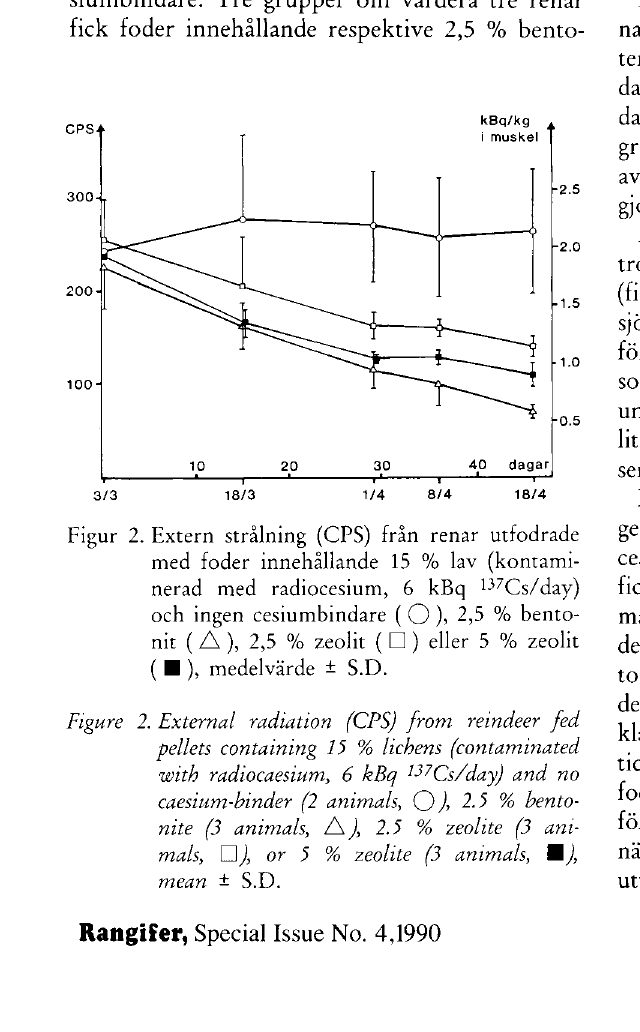
Figure 2. External radiation (CPS) from reindeer fed pellets containing 15 % lichens (contaminated with radiocaesium, 6 kBq 137 Cs/day) and no caesium-binder (2 animals, O), 2.5 % bento nite (3 animals, A ), 2.5 % zeolite (3 ani mals, U), or 5 % zeolite (3 animals, M), mean ±